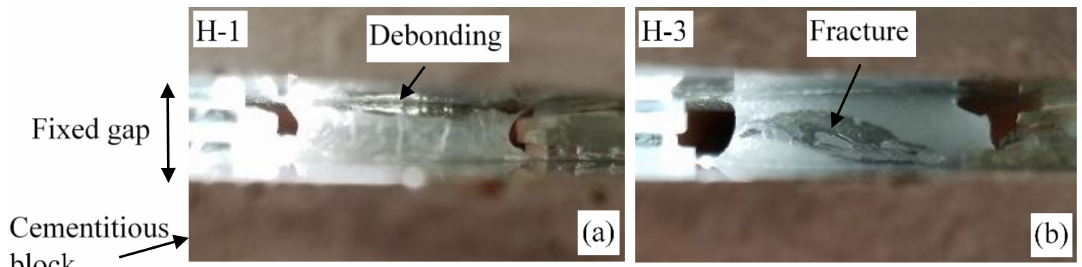
Figure 6. Images showing ( a ) debonding between H-1 and the cement paste block and ( b ) a fracture in H-3 in the desorption experiment setup with a fixed gap between the top and bottom cement paste